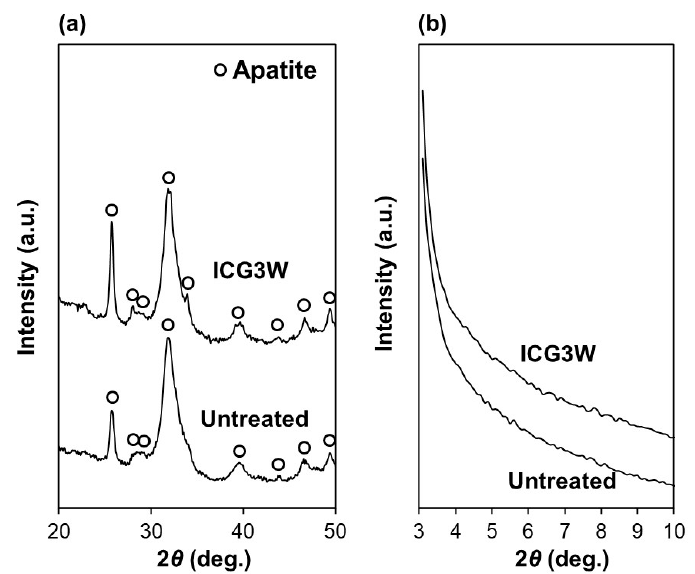
Figure 8. XRD patterns with ( a ) wide and ( b ) small angle regions of the surfaces of the untreated substrate and LAB-processed substrate ICG3W. The XRD patterns of both untreated and